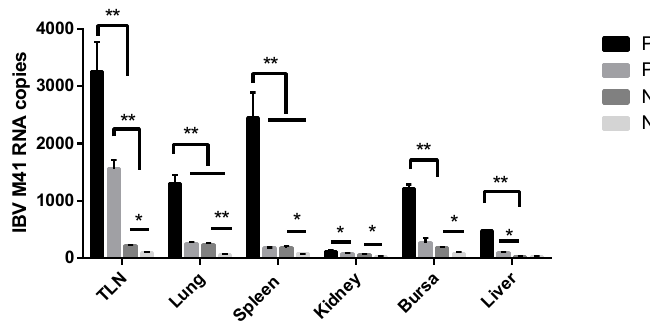
Figure 8. Changes of the IBV M41 RNA copies in the tissues of IBV M41-challenged chickens as determined by absolute quantitative polymerase chain reaction (qPCR). The formula of the standard curve is y = 3.2771x + 37.947, E = 102.0%, R 2 = 0.9971. A multiple t -test was used for statistical analysis; * p < 0.05, ** p < 0.01.